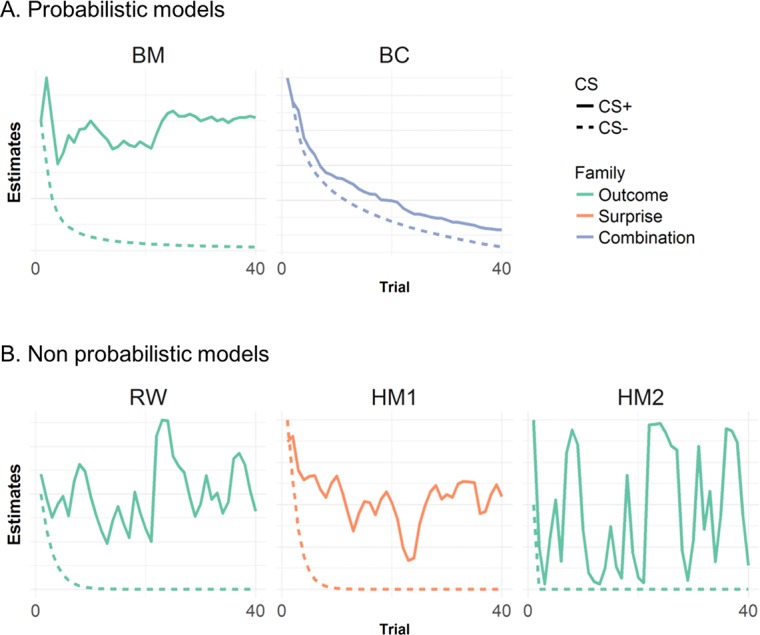
Predictions of probabilistic and non probabilistic RL models, grouped in families according to their predictions.For reasons of consistency with the ANS data displayed on Fig 1, we only show predictions of non-reinforced trials for CS+ (solid lines) and an equal number of CS- trials (equal to 40, dashed lines). (a) Model predictions for probabilistic models. Model predictions are illustrated according to whether they reflect a measure of the estimated CS value (green lines, outcome), the degree of surprise/model update (orange lines, surprise), or a combination of two quantities (purple lines, combination). (b) Model predictions for non probabilistic models, similar to -a-. This figure shows predictions for an exemplar trial sequence, to illustrate the trial-by-trial dynamics of each model. See S1 Fig for averages over 100 trial sequences, illustrating the general trends of the predictions.